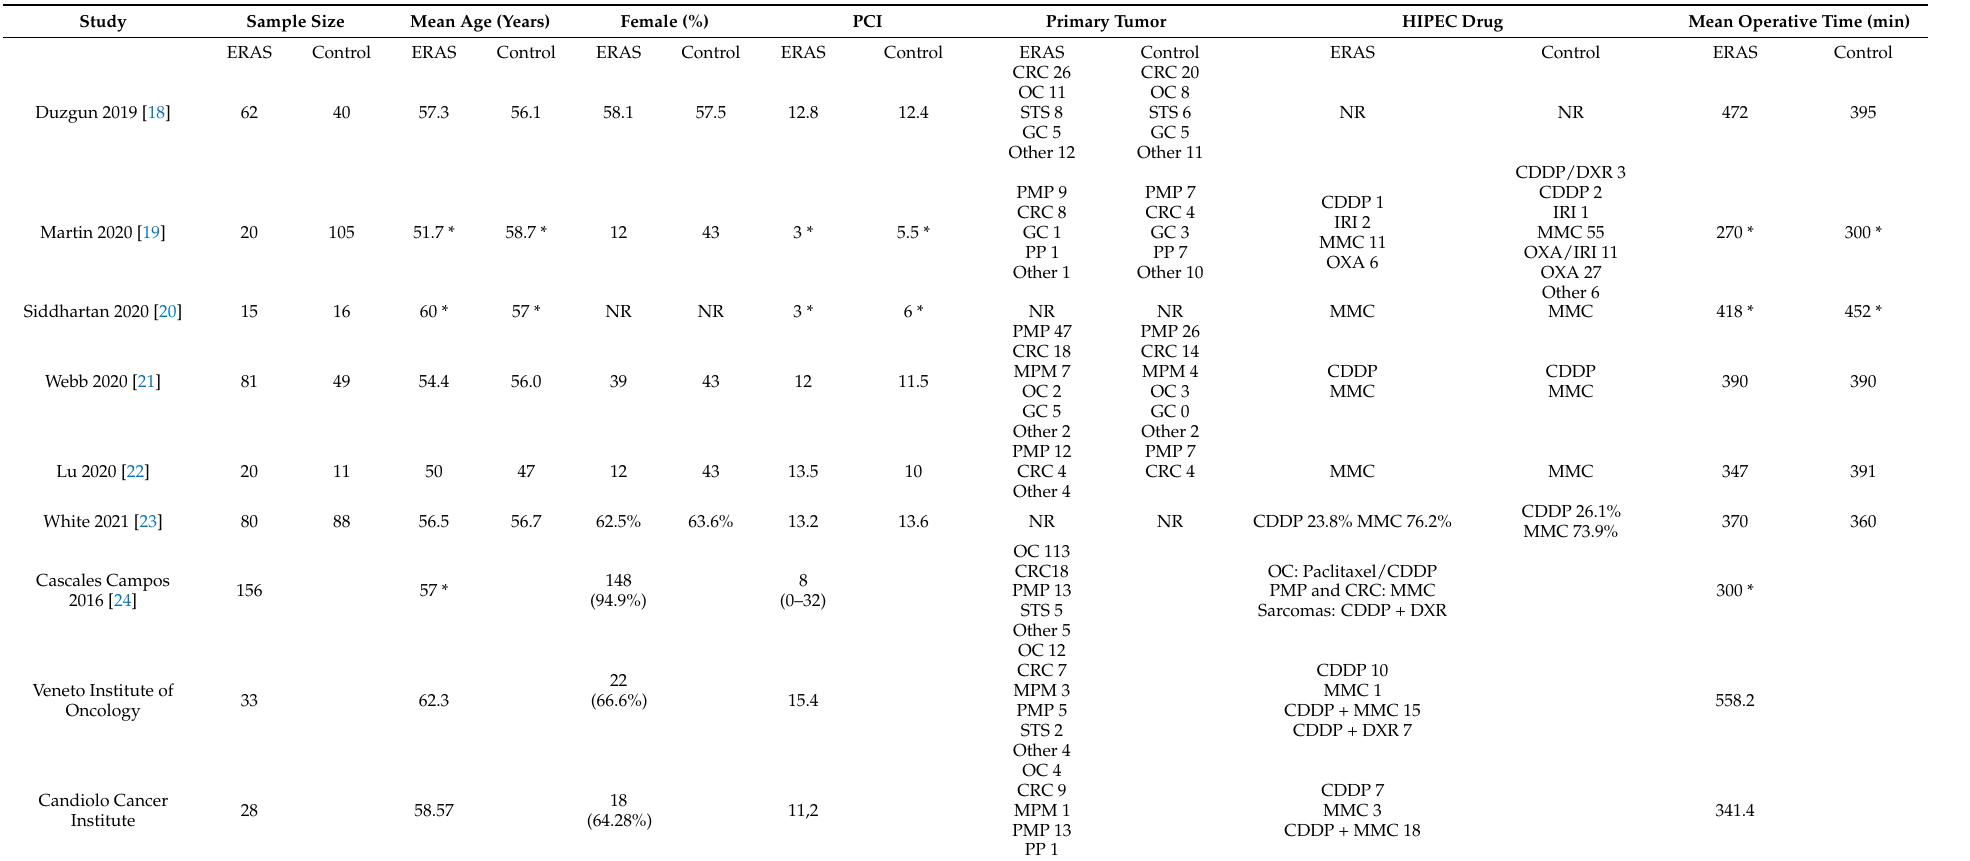
Table 1. Details of included studies about CRS +